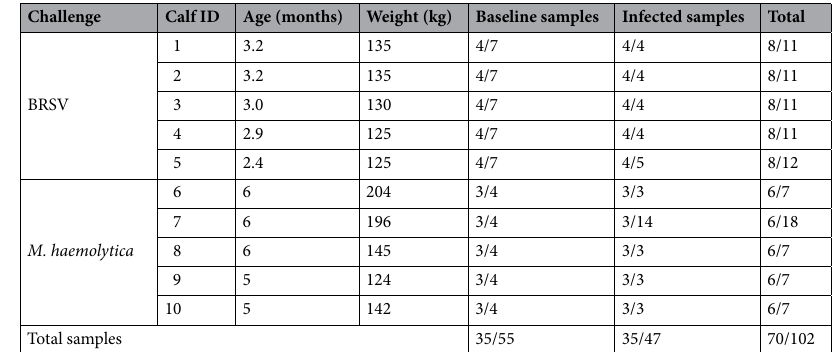
Table 1. Dairy calves and the total number of Baseline or Infected blood samples collected after pathogenic challenge. A subset of samples was selected for NMR metabolomic profiling because an even number of samples per category (Baseline or Infected) was needed to ensure variance and weight homogeneity of each data set for the multivariate